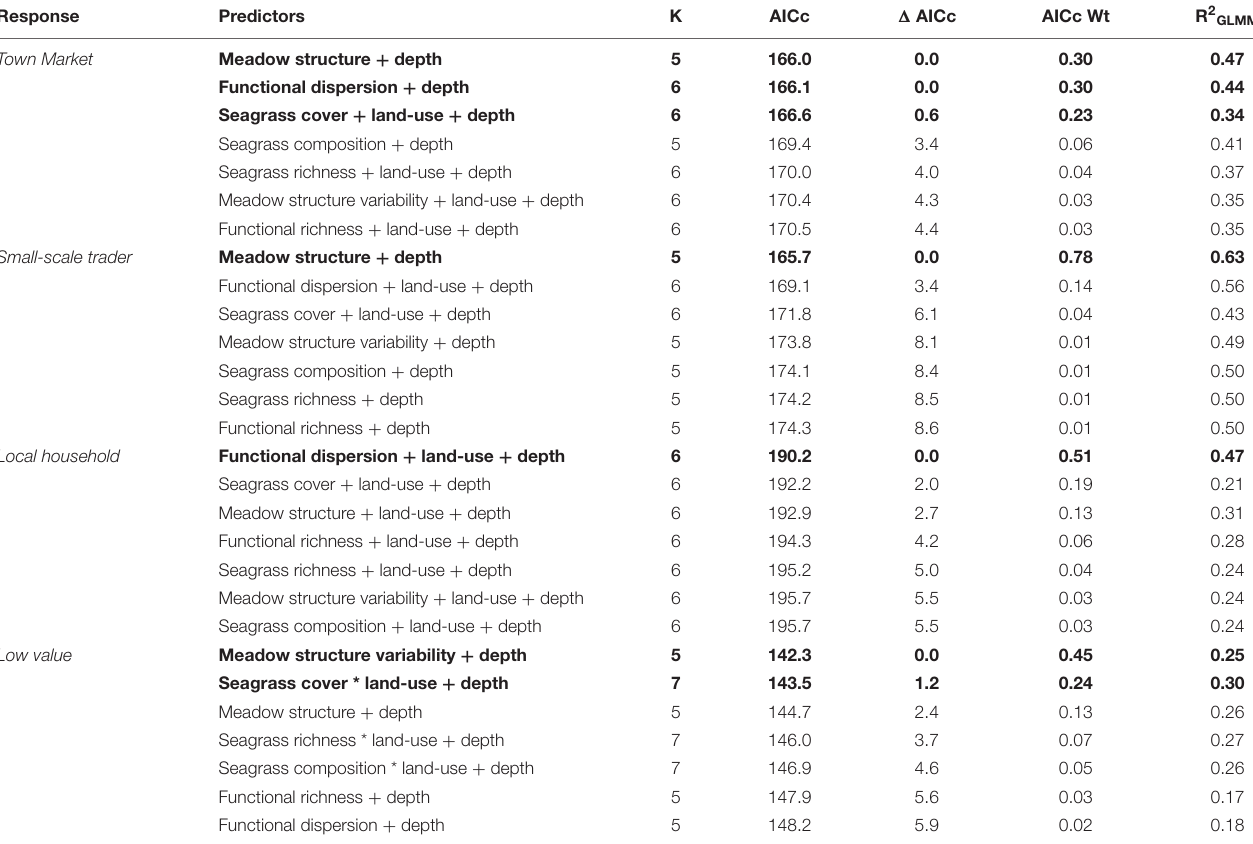
TABLE 5 | Candidate models for fish abundance across small-scale fishery sectors, sorted by AIC corrected for small sample sizes.